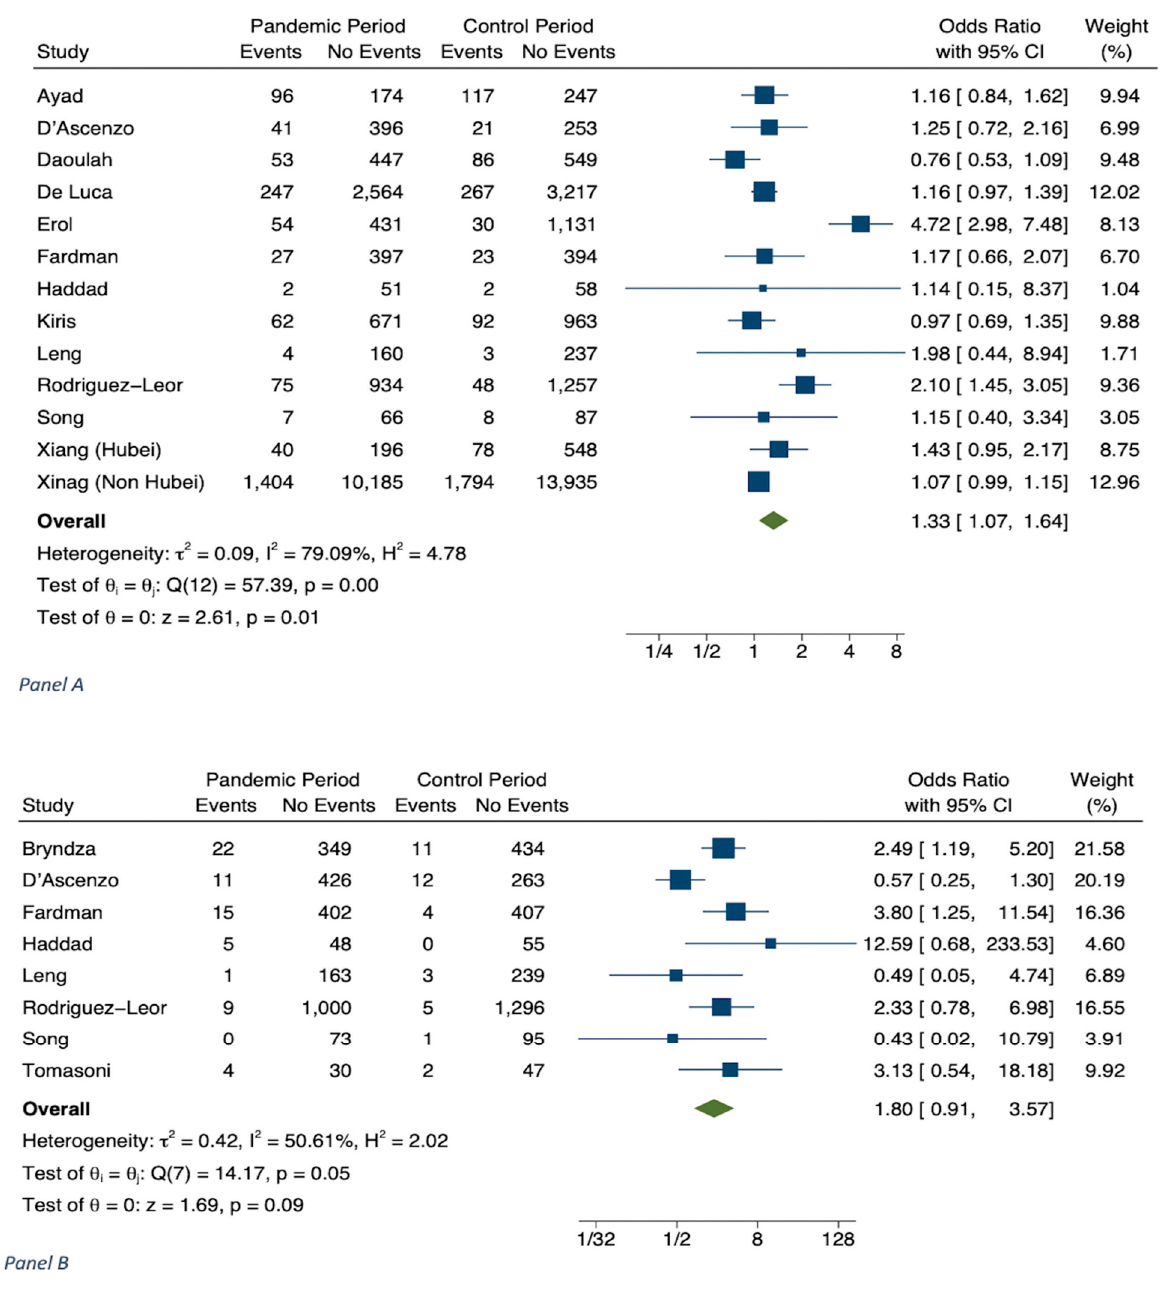
Figure 3. STEMI patients. Panel ( A ): Occurrence of cardiogenic shock during COVID-19 pandemic in 2020 vs. corresponding control period. Panel ( B ): Occurrence of mechanical complications during COVID-19 pandemic in 2020 vs. corresponding control period.